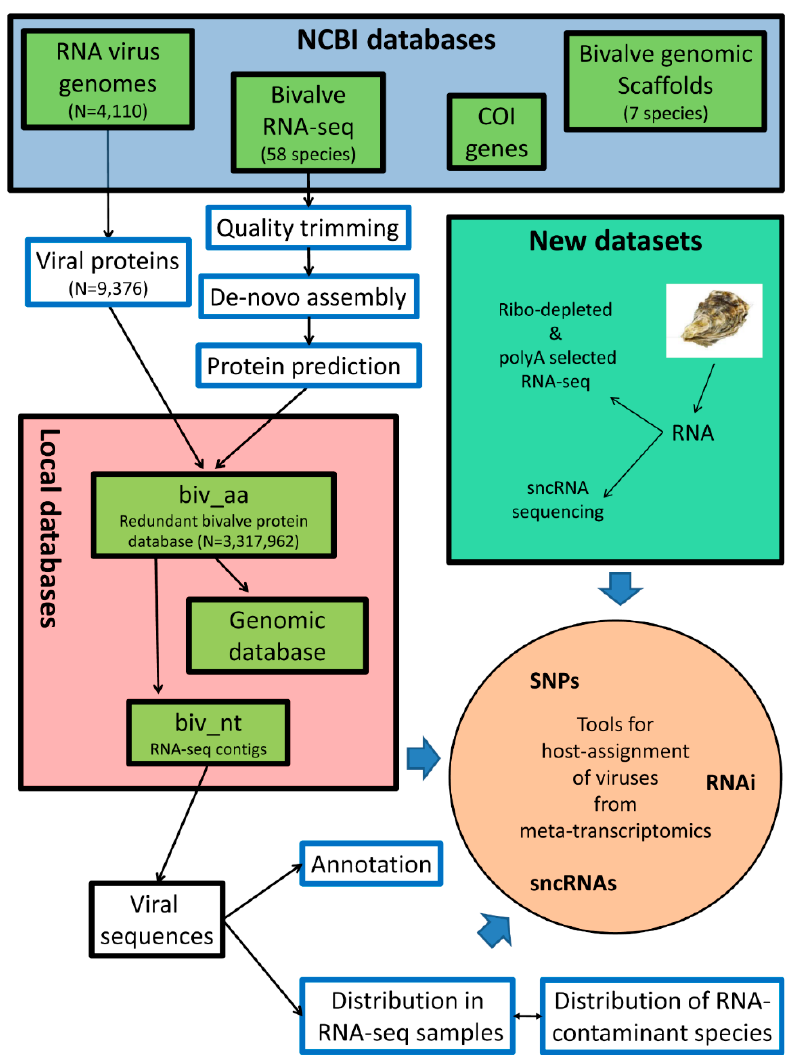
Figure 1. Summary of the analysis pipeline. The graph summarizes all of the steps that were used to extract viral sequences from bivalve RNA-seq datasets. Additional details are reported in corresponding sections of Materials and Methods.